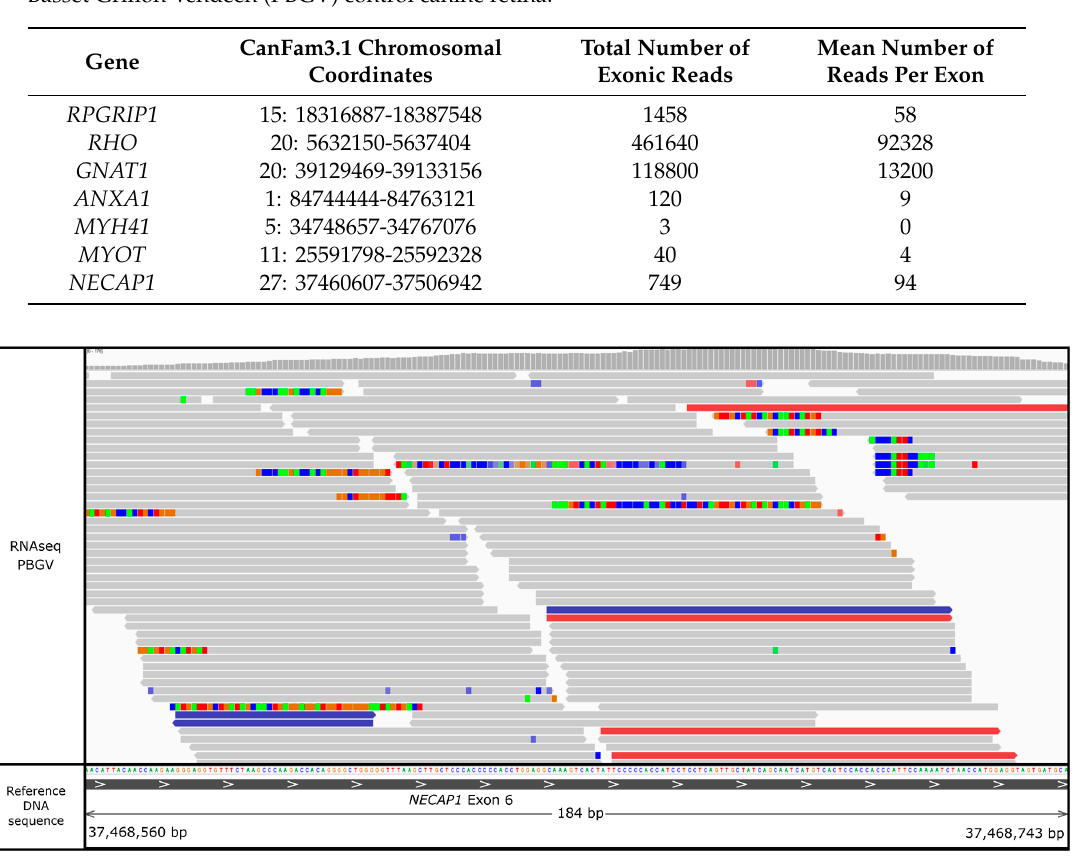
Figure 4. Alignment of RNAseq data in IGV from a control Petit Basset Griffon Vendeen (PBGV) retina to the CanFam3.1 canine genome show reads mapping to NECAP1 .